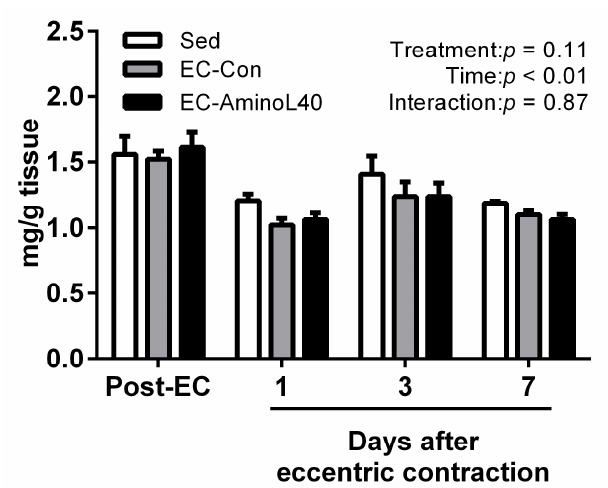
Figure 3. Adenosine di-phosphate (ADP) content in the tibialis anterior (TA) muscle immediately after eccentric contraction (Post-EC), 1, 3, and 7 days later. ADP was measured in the sedentary group (Sed), and in rats who underwent eccentric contractions and were given water (EC-Con) or a leucine-enriched essential amino acids mixture (EC-AminoL40). Data represent the mean ± SEM ( n = 4 (Sed) or 5 (EC groups)).